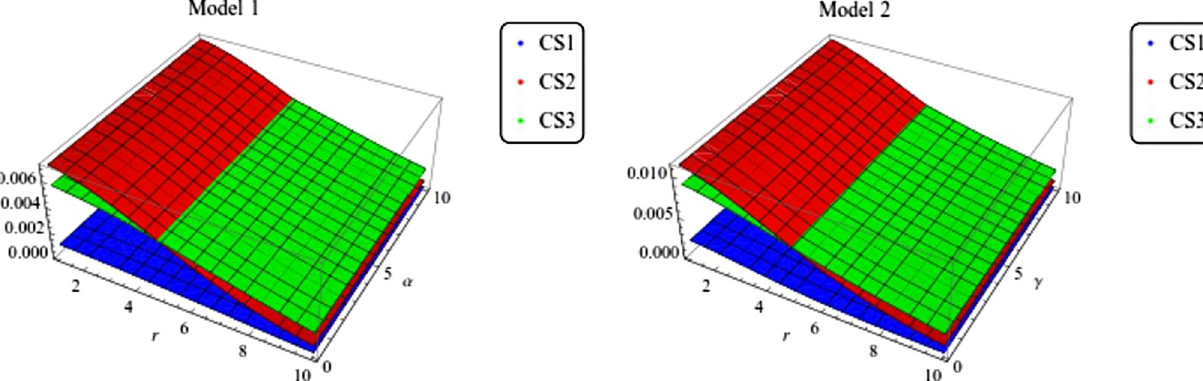
Fig. 3 Graph for the transverse pressure (km − 2 ) evolution with both f ( R , T ) models